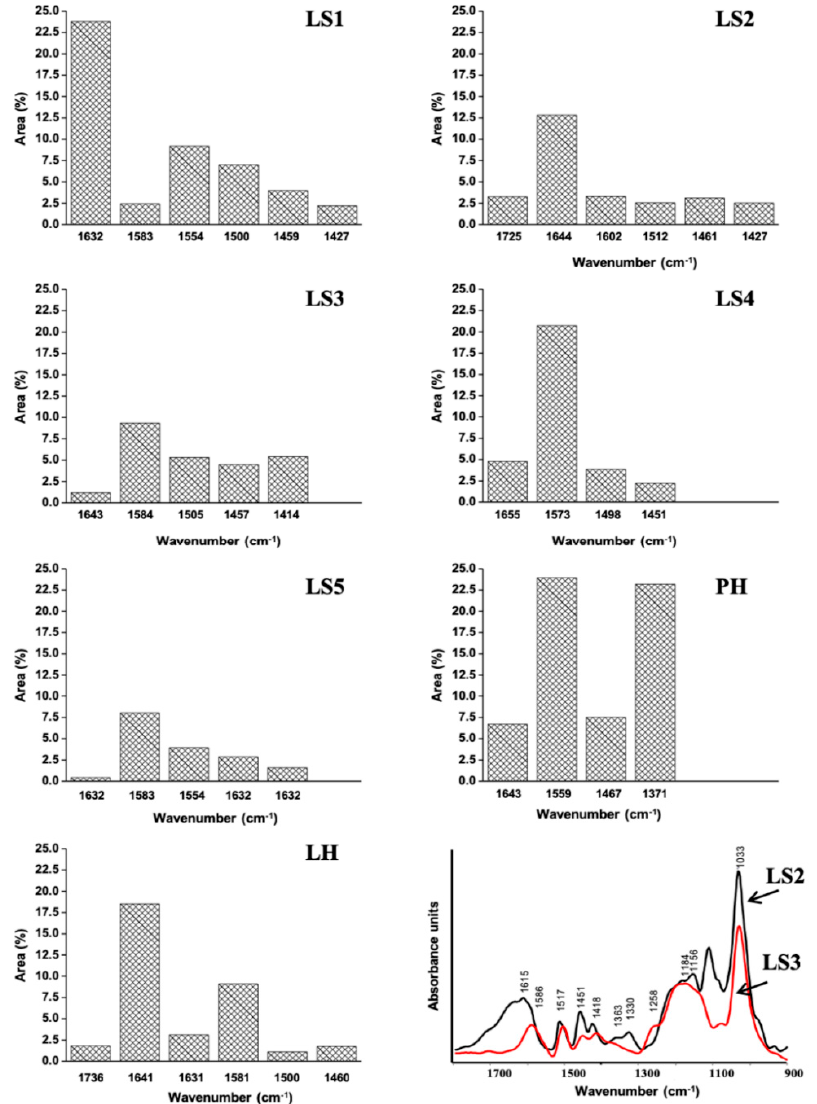
Figure 1. FTIR histograms of humates (Hs) peak areas processes by using curve fitting (from 1800 to 1370 cm − 1 ).